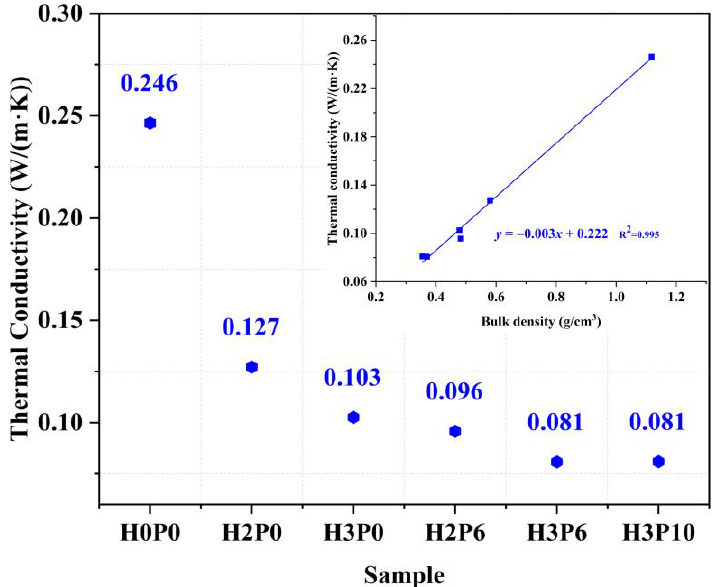
Figure 19. Thermal conductivity of matrix and geopolymer foams.